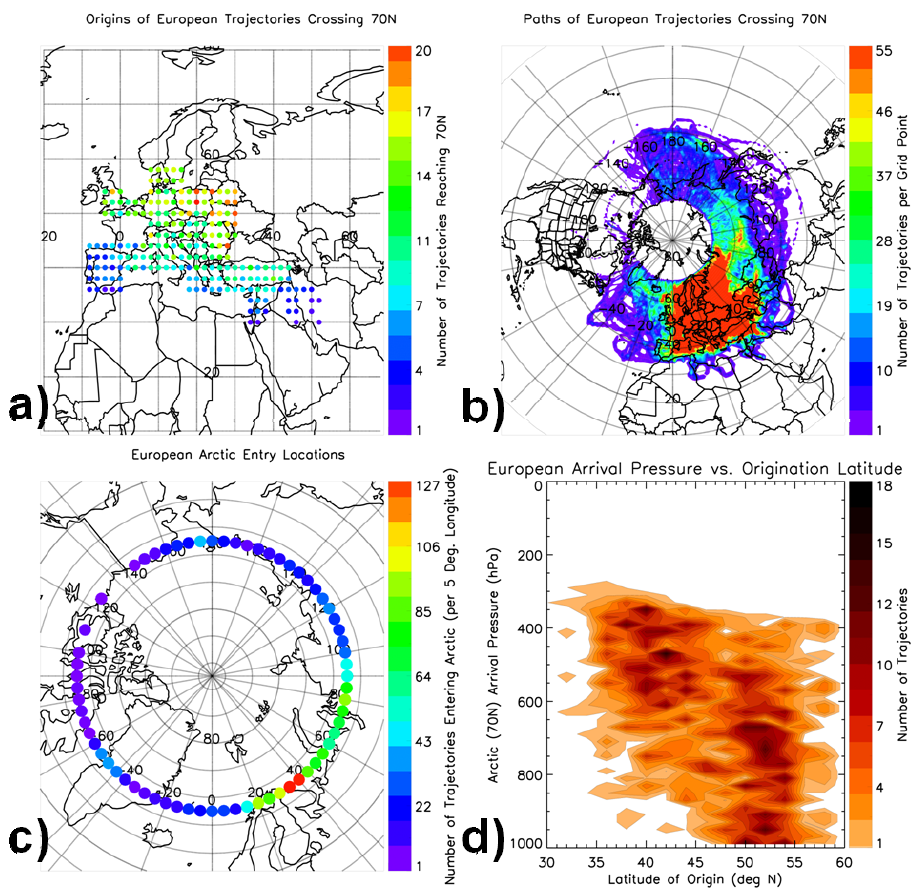
Fig. 13. As in Fig. 4, but for trajectories released from areas of European anthropogenic emissions.